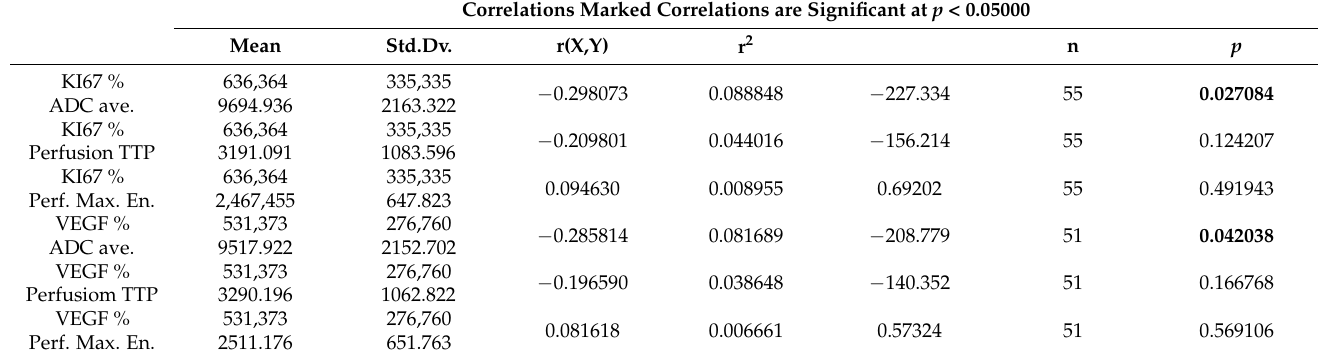
Table 4. Correlation between Ki67 and VEGF expression and diffusion (mean ADC) and perfusion parameters (TTP and Perf. Max. En.) in primary EOC tumor. Correlations Marked Correlations are Significant at p < 0.05000